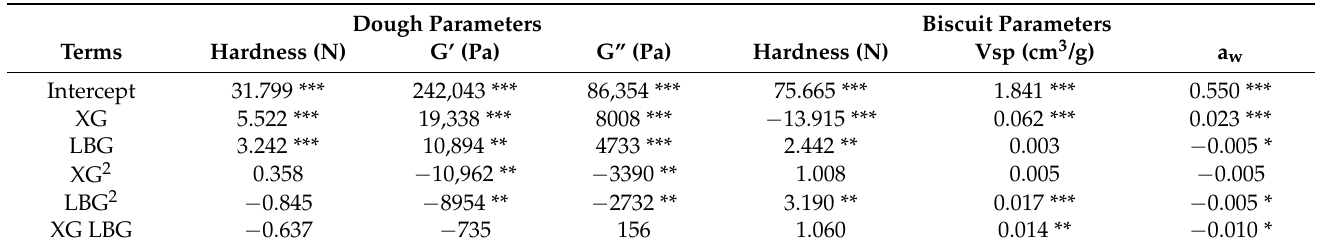
Table 4. Regression coefficients of the second order polynomial models and significant terms for different properties of gluten-free doughs and biscuits containing xanthan gum (XG) and locust bean gum